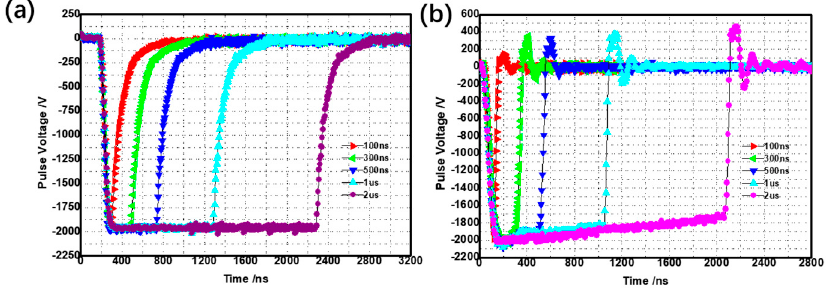
Figure 8. The voltages on the in-vitro loads with different widths in the nanosecond pulse mode. ( a ) The swine tissue load; ( b ) the cell culture cuvette load.